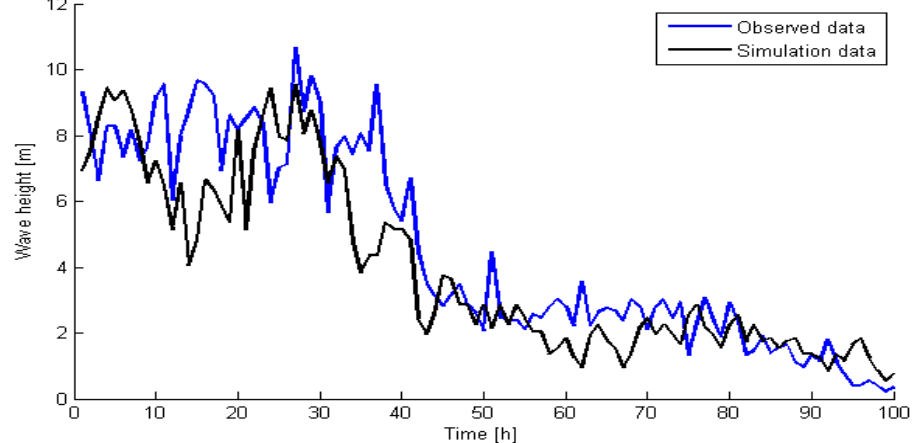
Figure 8. The comparison of predicted and observed values of wave height, wave height prediction curve with ∆ H s = 0.1 m.